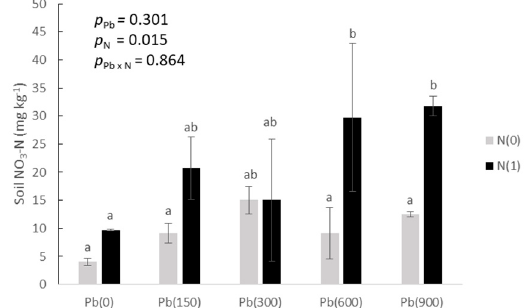
Figure 5. Residual N (as NO 3 -N) in soil cultivated with purslane as affected by the addition of Pb (0, 150, 300, 600, and 900 mg kg − 1 soil) and with (N1) and without added nitrogen (N0). Different letters above each bar denote significantly different treatments at p < 0.05.